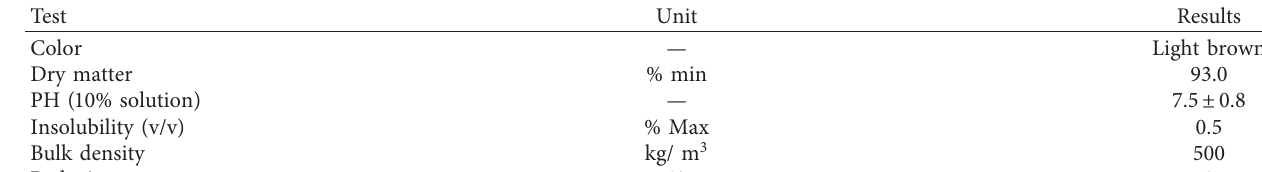
Table 4: Physical properties of the CLS